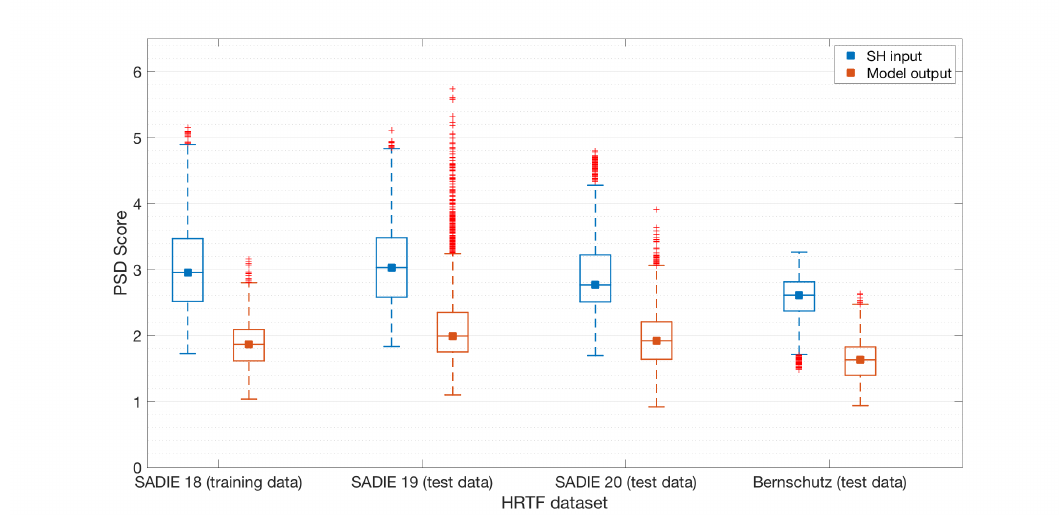
Figure 13. PSD median and box plot with whiskers with maximum 1.5 IQR which shows the model reduced the interquartile range (IQR) significantly.